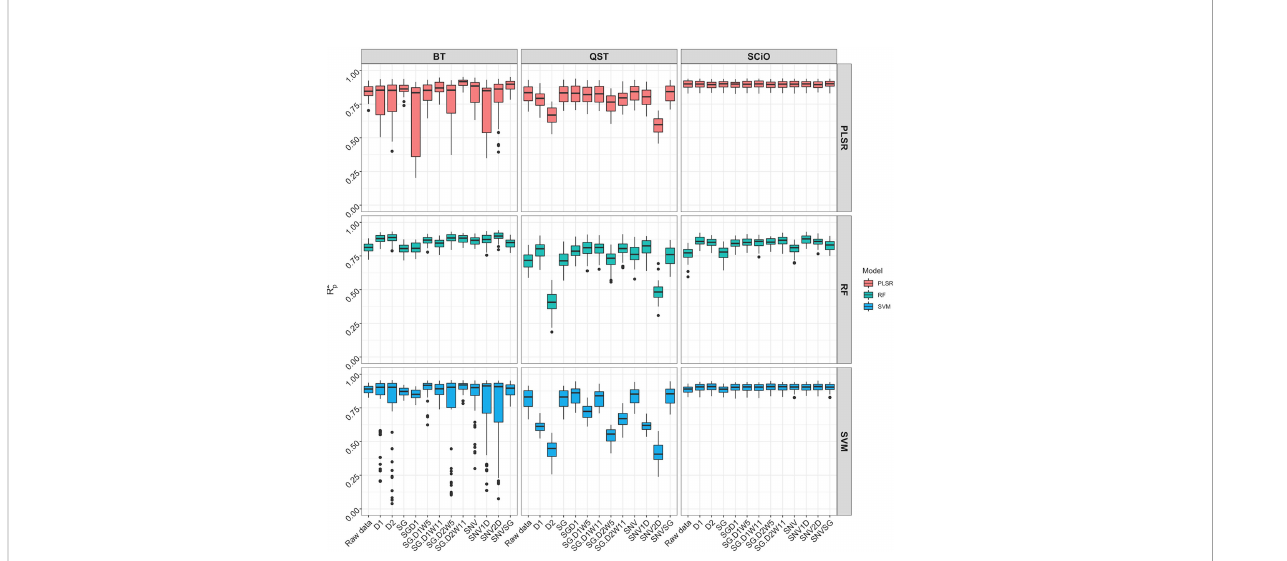
FIGURE 8 Comparison of model prediction using Partial least squares regression (PLSR), support vector machine (SVM) and random forest (RF) algorithms between ASD QualitySpec ® Trek (QST), the Benchtop FOSS XDS Rapid Content ™ Analyzer NIRS spectrometer (BT) and the pocket-size SCiO ™ (SCiO) using the overlapping wavelengths (740 1070 nm) between the three devices. The Y-axis shows the squared Pearson ’ s correlation between predicted and observed values in the test set ( R 2 P ). The X-axis indicates the model without spectral pretreatment (raw data) and the different pretreatment approaches used [standard normal variate (SNV), standard normal variate and fi rst derivative (SNV1D), standard normal variate and second derivative (SNV2D), fi rst derivative (D1), second derivative (D2), Savitzky-Golay with window size = 11 (SG), standard normal variate and Savitzky-Golay (SNVSG), gap segment derivative with window size = 11 (SGD1), Savitzky-Golay with window size = 5 and fi rst derivative (SG.D1W5), Savitzky-Golay with window size = 11 and fi rst derivative (SG.D1W11), Savitzky-Golay with window size = 5 and second derivative (SG.D2W5), and Savitzky-Golay with window size = 11 and second derivative